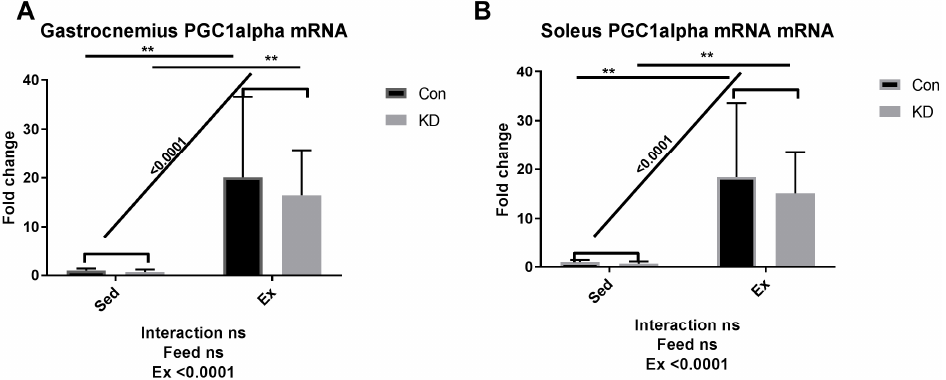
Figure 5. mRNA expression of peroxisome proliferator-activated receptor gamma coactivator-1alpha in gastrocnemius ( A ) and soleus ( B ). ns: no significance observed. ** p < 0.01. Significance between groups are marked using slashes.